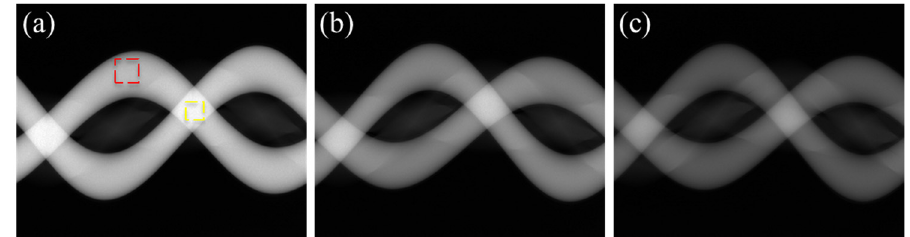
Figure 2. The sinograms made from the uncorrected projection data of the phantom with iodine concentrations of ( a ) 300 mgI/mL, ( b ) 150 mgI/mL, and ( c ) 75 mgI/mL, respectively.